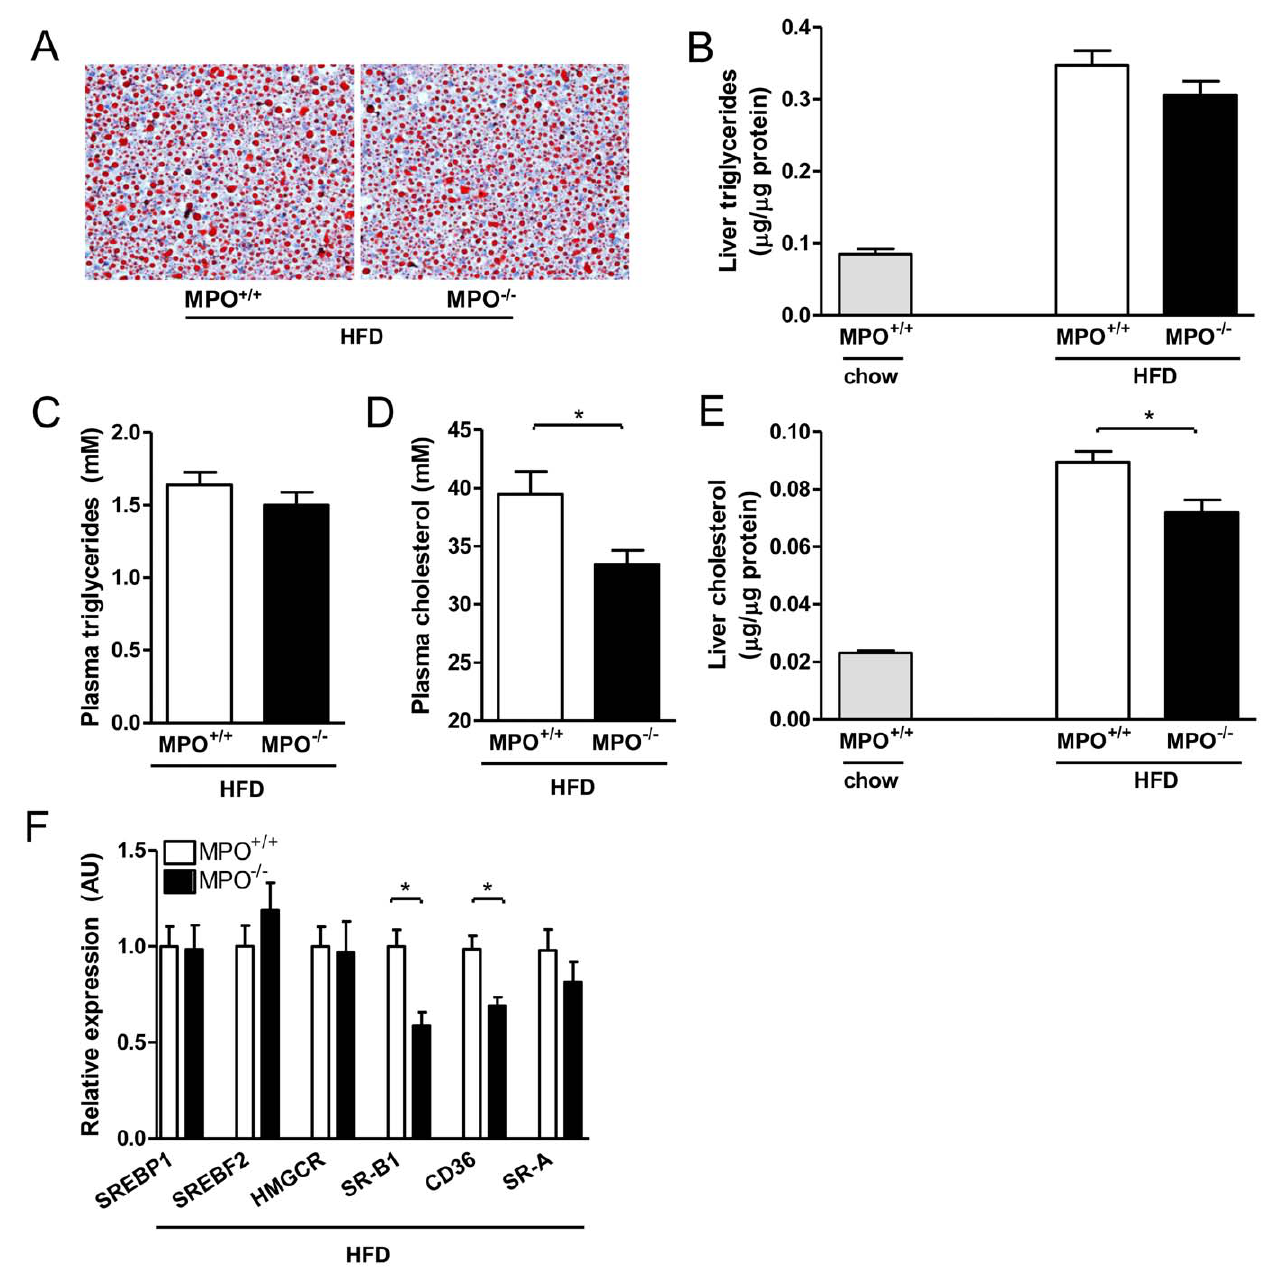
Figure 4. Decreased cholesterol accumulation in the liver of LDLR 2 / 2 / MPO 2 / 2 tp mice. A) Representative Oil red O stainings of liver sections of LDLR 2 / 2 / MPO 2 / 2 tp and LDLR 2 / 2 / MPO + / + tp mice fed a high-fat diet for 8 weeks, showing comparable lipid accumulation (100 6 magnification). B) Similar hepatic triglyceride levels in LDLR 2 / 2 / MPO 2 / 2 tp and LDLR 2 / 2 / MPO + / + tp mice after high-fat feeding (0.31 6 0.02 vs. 0.35 6 0.02 m g/ m g protein, p=0.24). Chow-fed LDLR 2 / 2 / MPO + / + mice show a lower level of liver triglycerides. C) Plasma triglyceride levels are similar in LDLR 2 / 2 / MPO 2 / 2 tp and LDLR 2 / 2 / MPO + / + tp animals after high-fat feeding (1.50 6 0.09 vs. 1.64 6 0.09 mmol/l, p=0.42). D) High-fat feeding results in higher plasma cholesterol levels in LDLR 2 / 2 / MPO + / + tp animals as compared with LDLR 2 / 2 / MPO 2 / 2 tp mice (33.5 6 0.1 vs. 39.5 6 2.0 mmol/l, p=0.02). E) Diet-induced liver cholesterol accumulation is reduced in LDLR 2 / 2 / MPO 2 / 2 tp mice compared with LDLR 2 / 2 / MPO + / + tp animals (0.072 6 0.004 vs. 0.090 6 0.004 m g/ m g protein, p=0.01), but does not reach the level observed in chow-fed LDLR 2 / 2 / MPO + / + mice. F) Hepatic mRNA expression of key enzymes in cholesterol metabolism is not altered in LDLR 2 / 2 / MPO 2 / 2 tp mice, whereas scavenger receptor expression is reduced (SR-B1 1.7-fold, p , 0.01; CD36 1.4-fold, p , 0.01, SR-A 1.2-fold, p=0.63). doi:10.1371/journal.pone.0052411.g004 apoB, an important component of LDL [29]. This may alter LDL by macrophages [30]. Identification of the relative impor- interaction with hepatocyte receptors and contribute to dyslipide- tance of these mechanisms for the observed reduction of total liver mia by affecting clearance. Furthermore, nitrotyrosine formation and plasma cholesterol levels will require detailed analysis of on apoB-100 leads to enhanced uptake of cholesterol-containing lipoprotein profiles. In view of mounting evidence that Kupffer